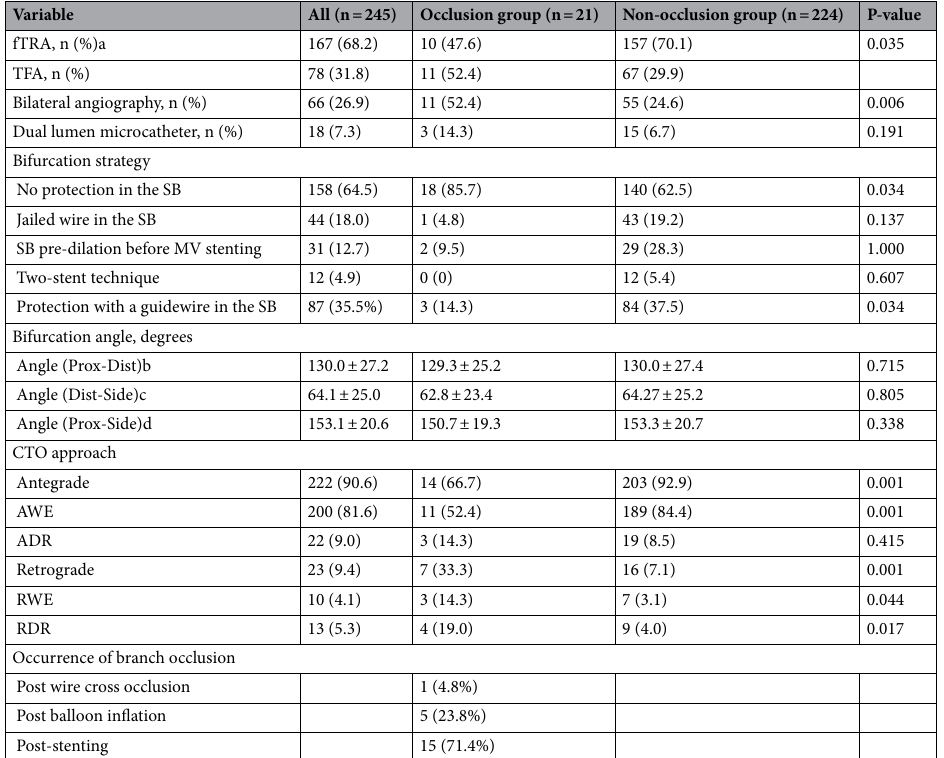
occlusion group (33.3% vs 7.1%; P = 0.001). The SB was not protected in 158 patients (64.5%), a jailed wire was used in 44 (18%), an SB pre-dilation technique in 31 (12.7%), and a two-stent technique in 12 (4.9%). The num- ber of SB which was protected with a guidewire before MV stent implantation was 87 (35.5%), and the number of SB not protected was 158 (64.5%). In this study, only a very small number of patients (7.3%) used dual-lumen microcatheter. And there was no significant difference in the proportion of using dual-lumen microcatheters between the occlusion group and non-occlusion group (14.3% vs 6.7%, P = 0.191). No SB protection was found to be more common in the occlusion group (85.7% vs 62.5%; P = 0.034). In the branch unprotected group, SB occlusion occurred in 18 (11.4%) patients. However, in the branch protection group, only 3 cases (3.4%) had SB occlusion. There were no significant between-group differences in the angles between the MV and SB. In the Occlusion group, most of the SB occlusions (71.4%) were observed after the implantation of the stents. In this study, after the implantation of stent in MV, 15 cases occured branch occlusion. And only 5 patients (33.3%) suc- cessfully rewired to the SB and completed post dilation. Unadjusted analysis of periprocedural complications. Periprocedural complications were observed in 30 patients (12.2%) in the study. The composite procedural complication rate was 33.3% (7/21) in the occlu- sion group and 10.3% (23/224) in the non-occlusion group ( P = 0.007). The incidence of PMI was also higher in the occlusion group (19.0% vs 5.4%; P = 0.037). In this group, 2 patients (9.5%) had major bleeding and 1 (4.8%) had CIN. In the non-occlusion group, 4 (1.8%) patients had major bleeding and 2 (0.9%) developed CIN (Table 4). There was no significant between-group difference in the perforation rate. No instances of emergency CABG or death were ascertained. Logistic regression analysis for potential risk factors. Univariable logistic regression analysis was performed for all potentially important clinical and angiographic variables. Factors associated with occlusion of SB included previous PCI, length of occlusion, MV reference diameter, SB reference diameter, no SB protec- tion, 50% or more ostial SB stenosis ,50% or more proximal MV stenosis, and a dissection-reentry strategy were P < 0.10. These variables were included in the multivariable model. On multivariate analysis, no SB protection (odds ratio[OR] 4.61, 95% confidence interval [CI] 1.25–17.04; P = 0.022), 50% or more ostial SB stenosis (OR